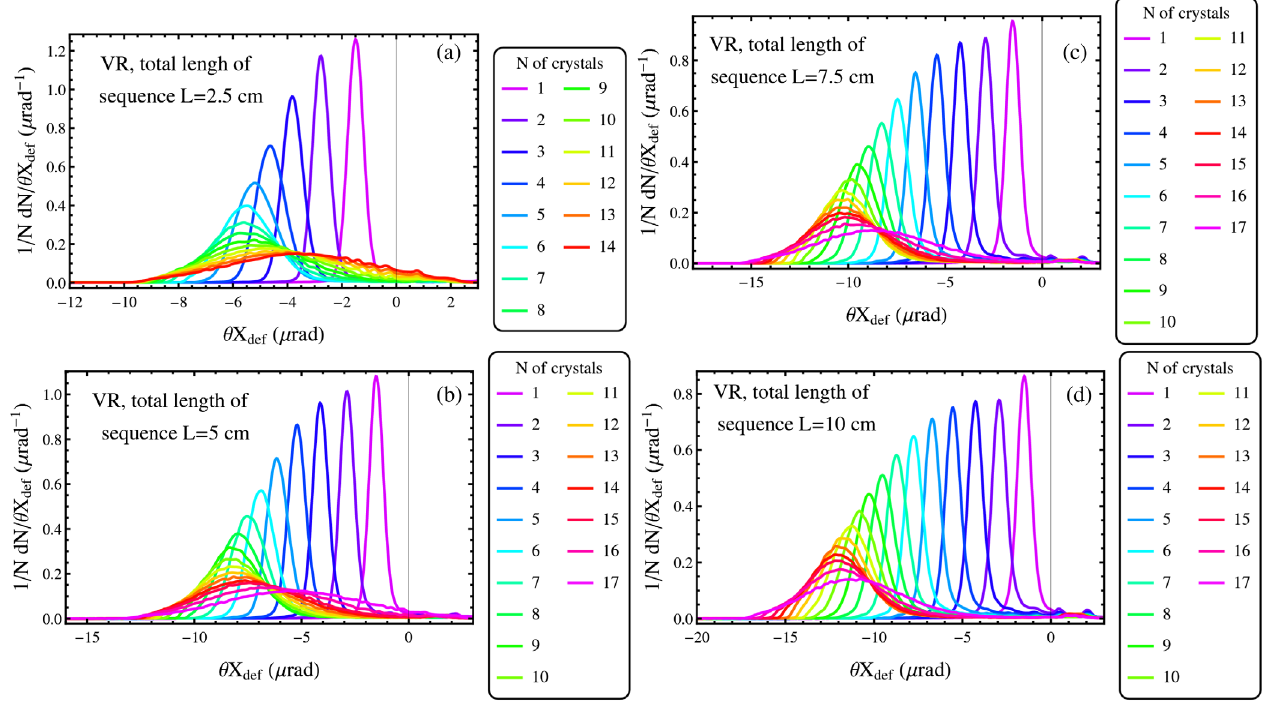
FIG. 5. Angular distribution behind the crystal for volume reflection of 50 TeV protons in a sequence of (110) bent silicon crystals. Bending radius is calculated according to (6). Fig. 6. While in vertical direction these reflections almost marized. For h 111 i silicon crystal axes MVROC deflection one [18 – 19], which was confirmed experimentally [21 – 23].